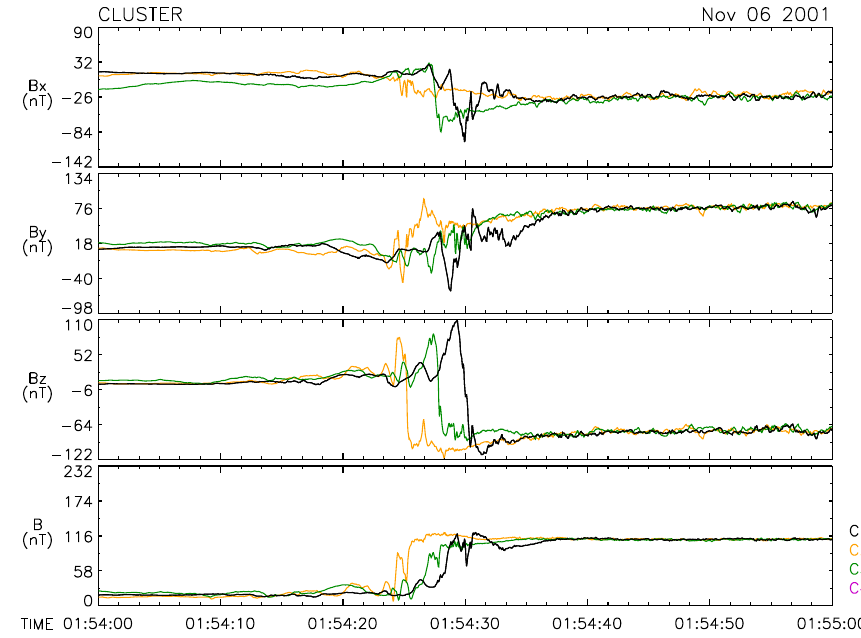
Fig. 17. High resolution Cluster magnetic field measurements on 6 November 2001. Note that a plot covers only a one-minute time interval (01:54:00–01:55:00 UT).